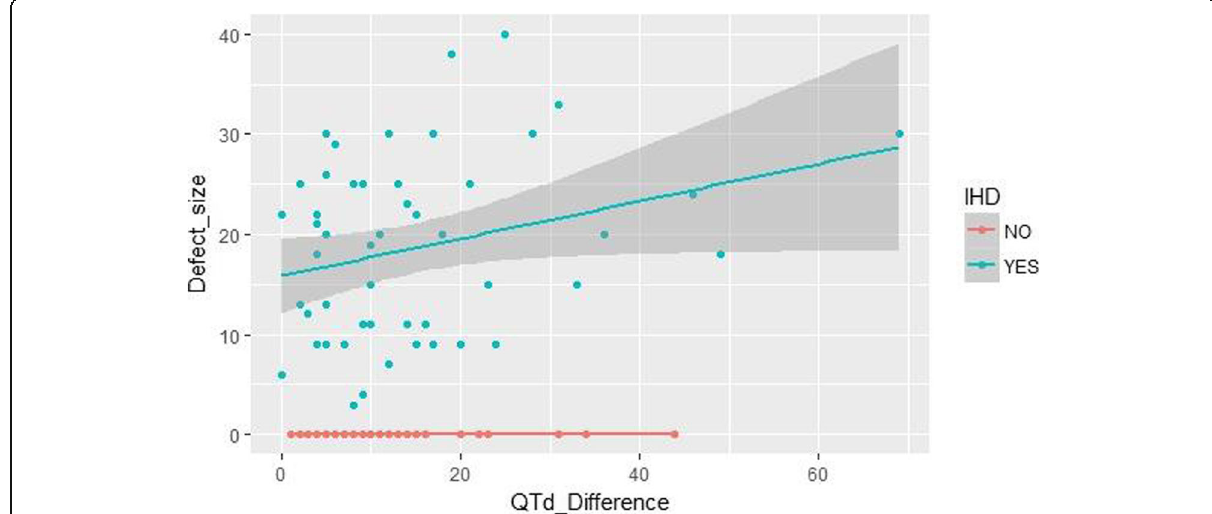
Fig. 1 Correlation between defect size and QTd difference in both studied groups